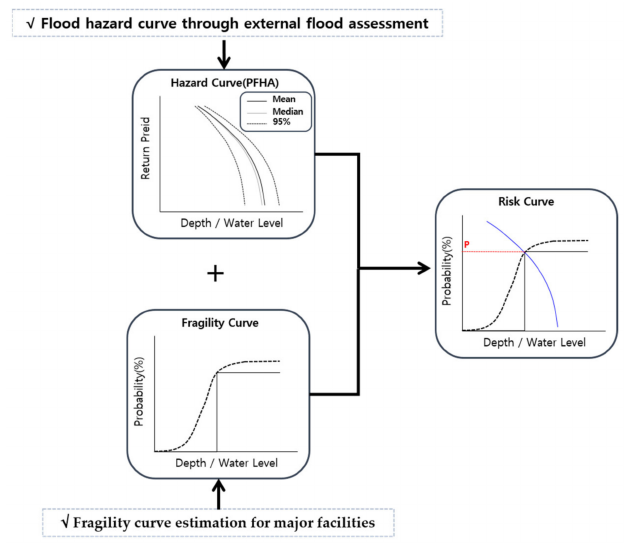
Figure 2. Probabilistic flood assessment